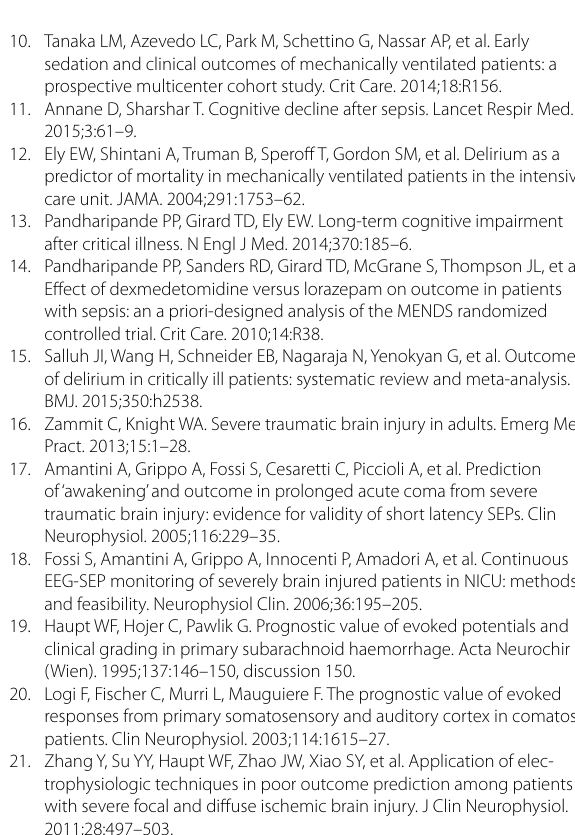
Fig. 3 Schematic representation of brainstem auditory evoked potentials (BAEP) responses localizations on a brain MRI ( a ) and typical examples of their normal wave forms as well as recording montage ( b ). BAEP elicited by auditory click (100‑µs 80‑dB) applied to one ear, with a ( ing of the contralateral ear by “white noise.” The recurrence frequency was 19.3 Hz (bandpass, 150–1500 Hz; sweep time, 10 ms). BAEP were picked up in Fz. with the reference electrode placed at the earlobe ipsilateral to the stimulated ear (Fz—A1 or A2). Two sets of 2000 sweeps were averaged. The I – III IPL represents the peripheral conduction time of the auditory pathway, when the III – V IPL represents the intrapontine conduction time